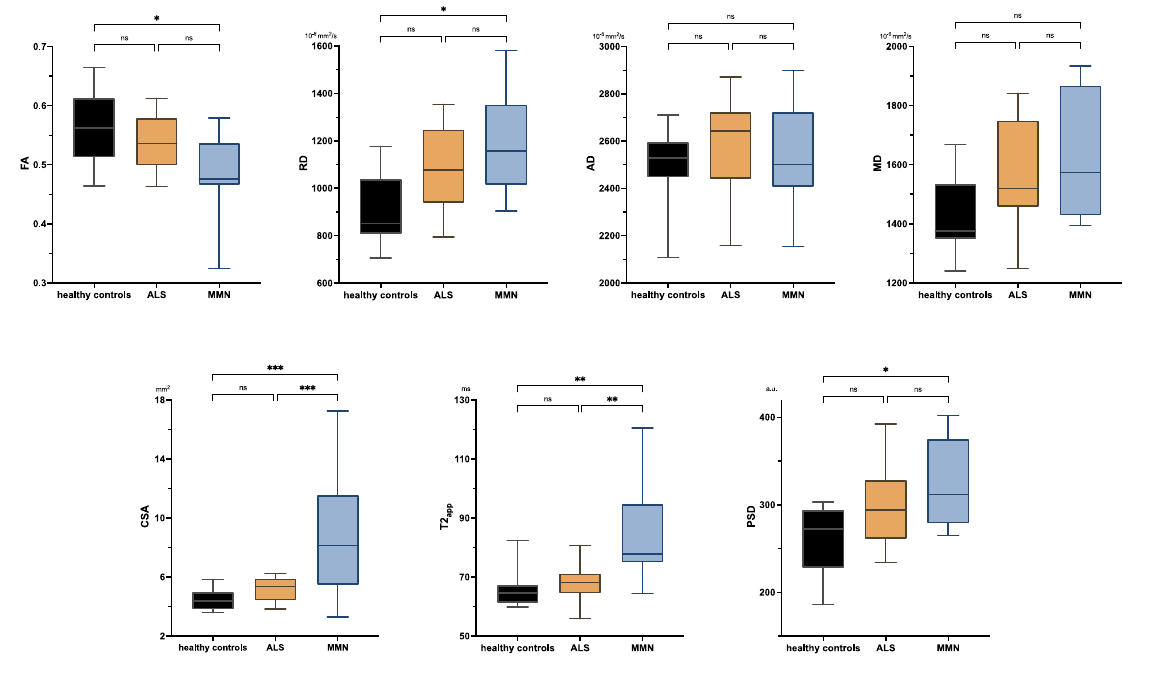
Figure 2. Boxplots of DTI parameters (upper row), cross-sectional area (CSA), and T2-relaxometry metrics (lower row) measured in the upper-arm nerves. Asterisks represent statistical significance at p ≤ 0.05 from one-way analysis of variance with Holm–Sidak’s correction. The plots illustrate the 25–75th percentiles (boxes) and minimum-to-maximum values (whiskers). Ns, not significant. There were no signi fi cant di ff erences between ALS patients and healthy subjects in any comparison either at the upper or lower extremity. Neither were there any signi fi cant di ff erences in the tibial nerve at the thigh or calf between MMN, ALS, or the control group Figure A1). Values are listed in Appendix B Table A2.